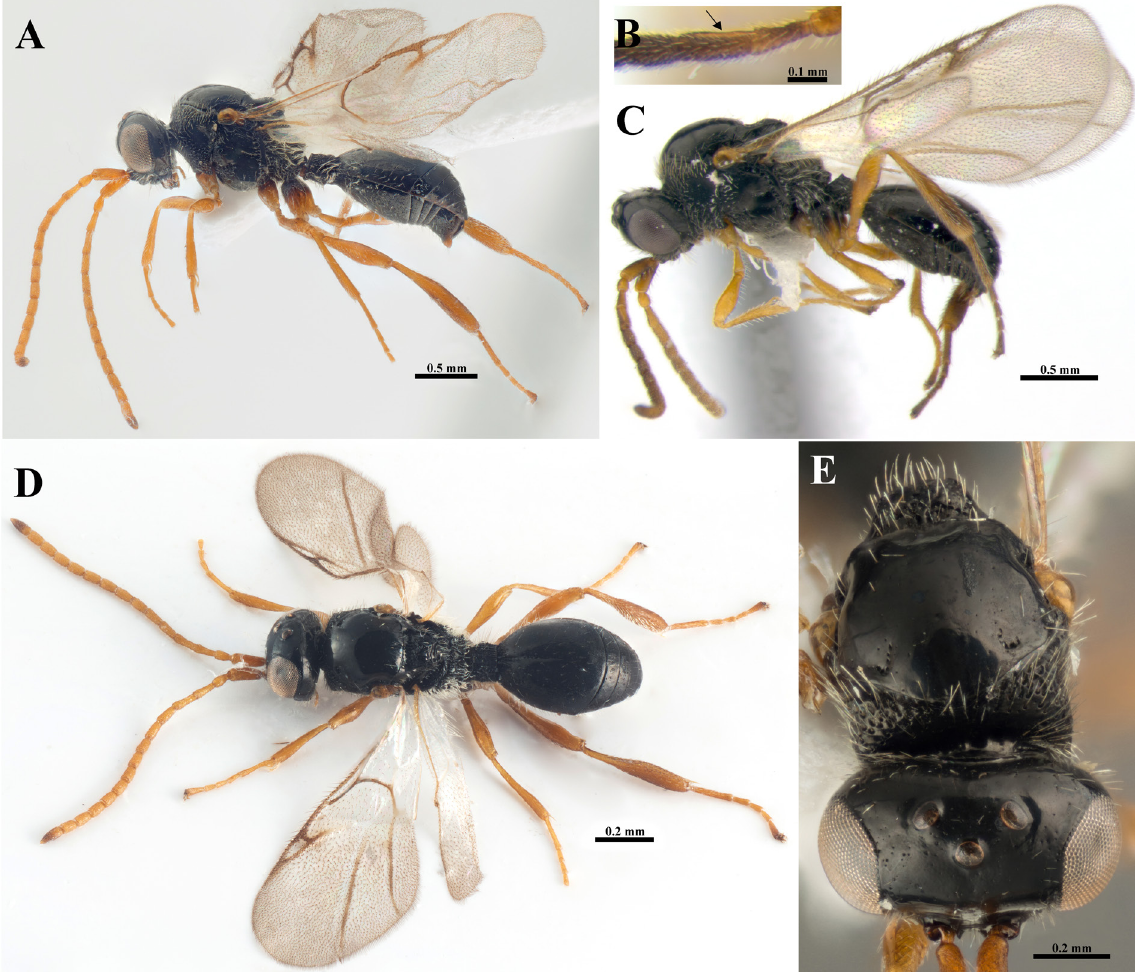
Fig. 4. Ismarus distinctus Kim, Notton & Ødegaard sp. nov. (A, D–E. Holotype, ♀; B–C. Allotype, ♂) . A . Habitus in lateral view. B . Antenna (A3–A5). C . Habitus in lateral view. D . Habitus in dorsal view. E . Head, Mesosoma in dorsal